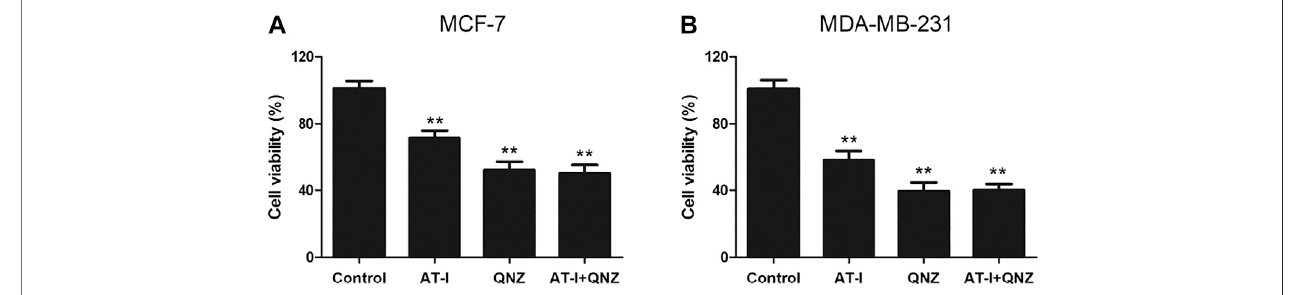
FIGURE 8 | Effects of AT-I and QNZ on cell viability. MCF-7 and MDA-MB-231 cells were treated with 100 μ M AT-I, 50 nM QNZ or their combination for 48 h, and MTT assay was adopted to determine cell viability. Signi fi cant differences between different groups were indicated as * p < 0.05, ** p < 0.01, vs. control group, n (cid:1)